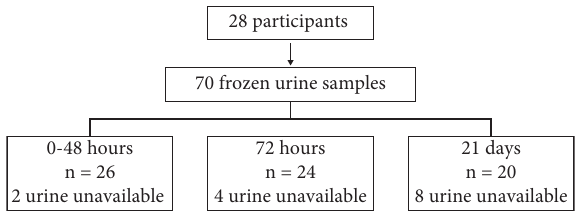
Figure 1: Study population. A total of 70 frozen urine samples from 28 very preterm neonates were available. Of the 70 urine samples, 26 samples were collected at 0–48 hours, 24 samples were collected at 72 hours, and 20 samples were collected at 21 days. Table 1: Baseline characteristics.